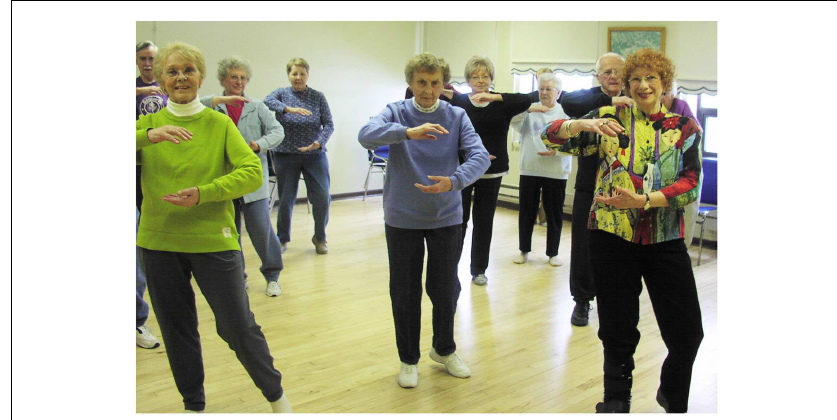
FIGURE 1 |Y-MFBB Class in Broome County,